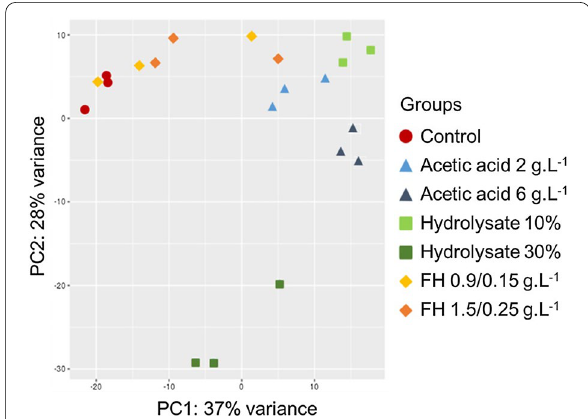
Fig. 2 Principal component analysis (PCA) of RNA-seq data of P. pastoris cultivated in different inhibitors. Dots represent samples and are colored according to the different conditions investigated: red circle: Control—minimal medium without inhibitor, light blue triangle: acetic acid 2 g.L − 1 , dark blue triangle: acetic acid 6 g.L − 1 , light green square: hydrolysate 10%, dark green square: hydrolysate 30%, yellow diamond: FH 0.9/ 0.15 g.L − 1 , and orange diamond: FH